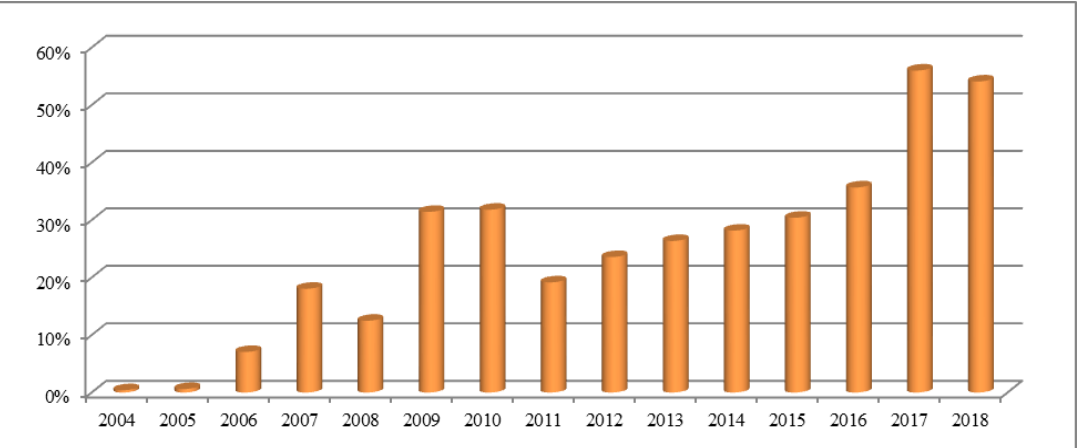
Figure 1. Stock market capitalization to GDP